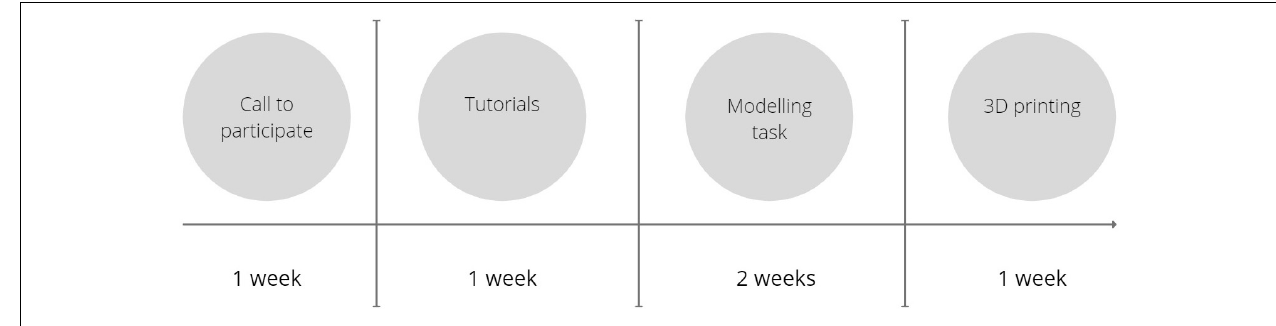
FIGURE 1 | Experience timeline in remote STEAM teaching in early childhood